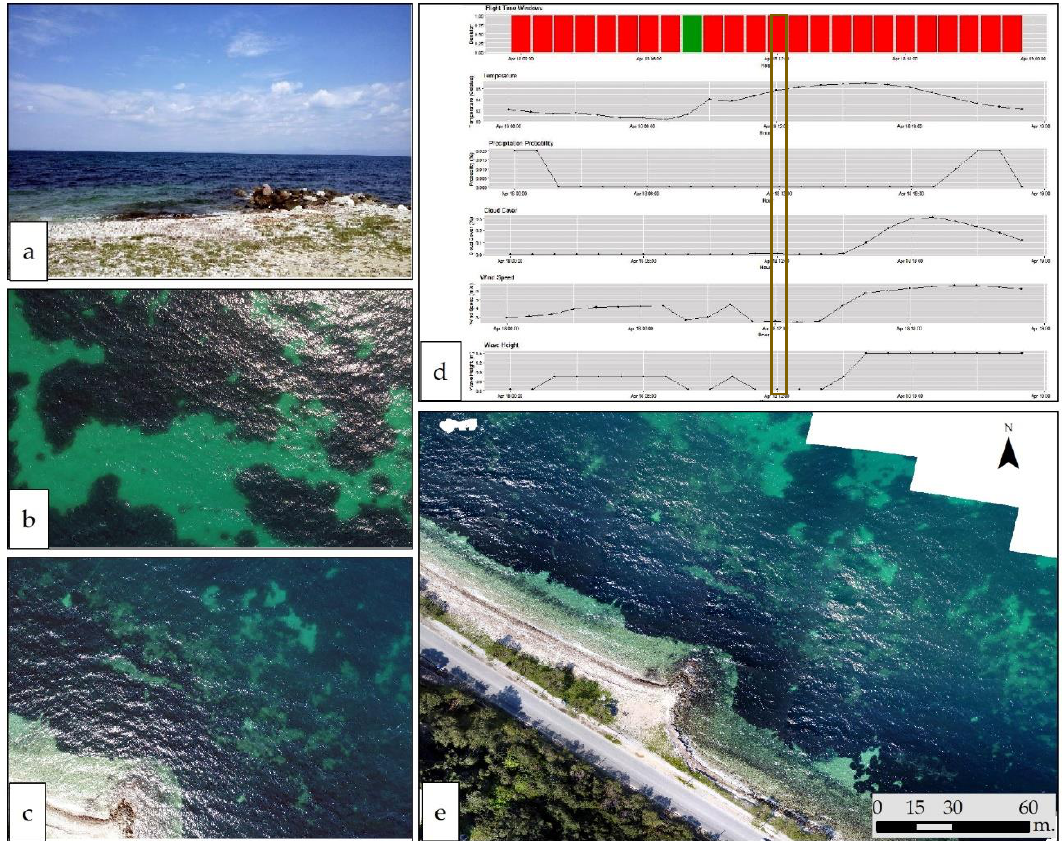
Figure 5. ( a ) View of the study area from a terrestrial image; ( b , c ) Nadir aerial images taken on 18 April 2019; ( d ) Result of the UAS toolbox the day of the flight survey; ( e ) Produced orthophoto